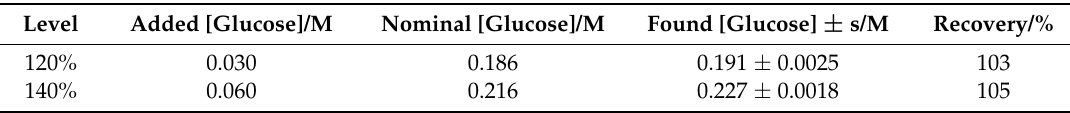
Table 4. Recovery of glucose in added lemon soft drink